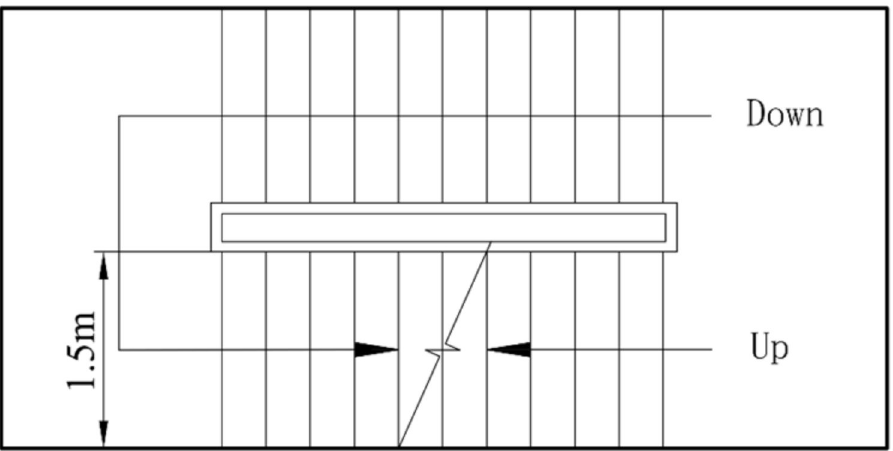
Figure 2. The double-run